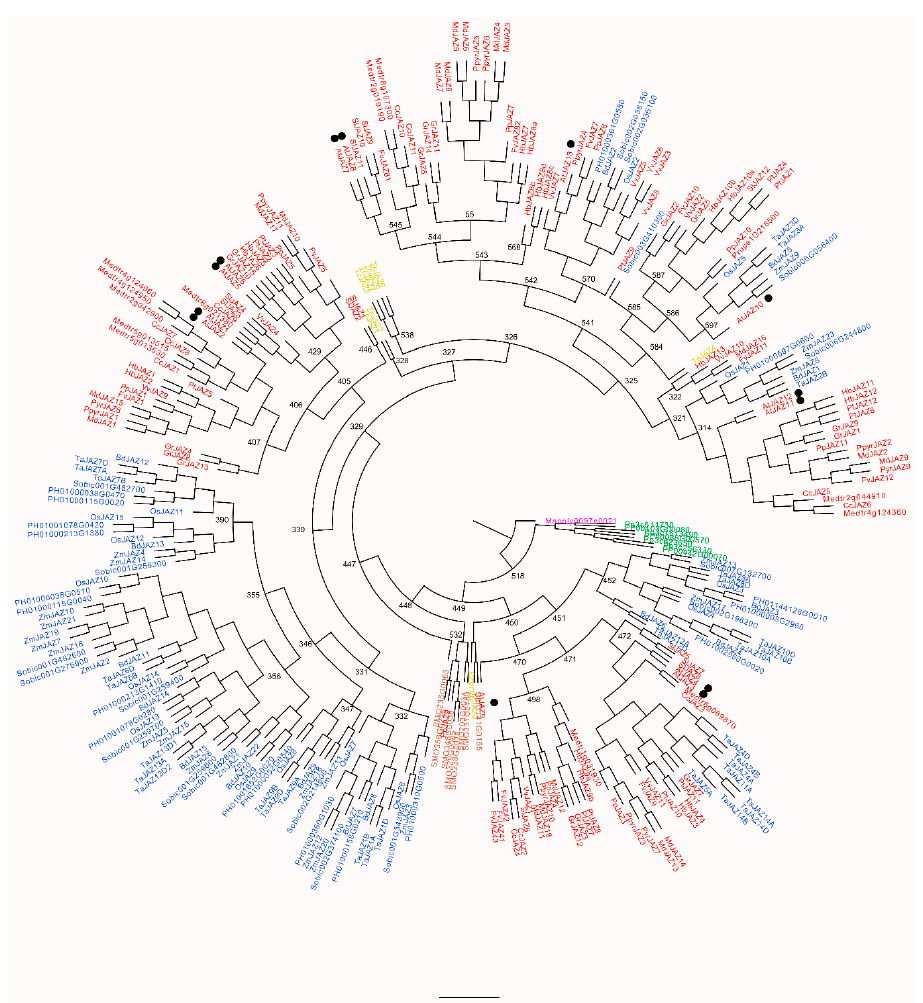
Figure 7. Reconstruction of JAZ ancestral sequences in land plants. The ancestral tree was performed using 308 full-length sequences corresponding to liverwort, moss, lycophyte, gymnosperms, monocots and dicots. Node numbers indicate some output ancestors obtained by using the PhyloBot software. The analysis of JAZ ancestral sequences is available to download at the following URL: http: //